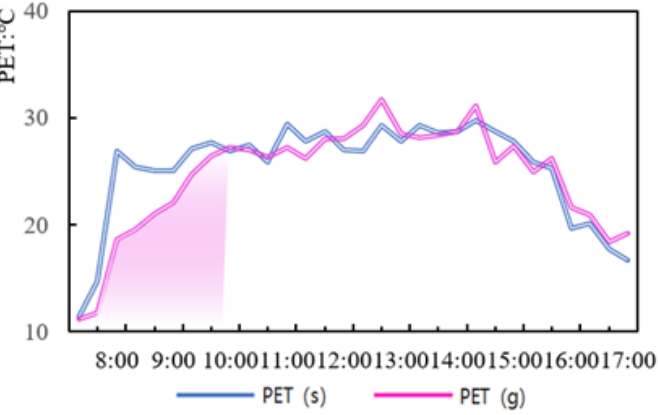
Figure 13. PET calculation results of representative day in transition season. The shaded part in the figure indicates the time period when the gap between PET (s) and PET (g) is obvious.